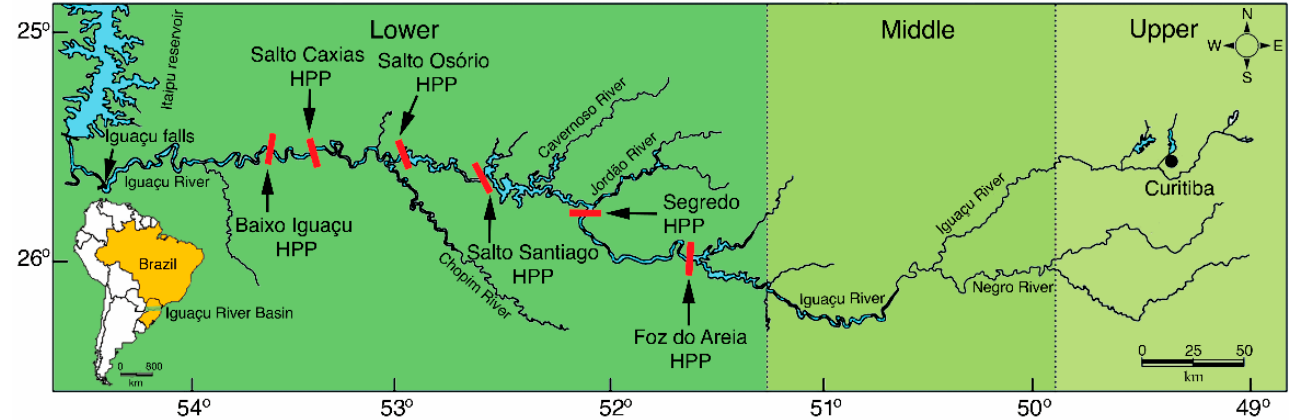
Figure 1. Map showing the location of six hydroelectric power plants (HPP) (red bars) built in the main channel of the Lower Iguaçu River.